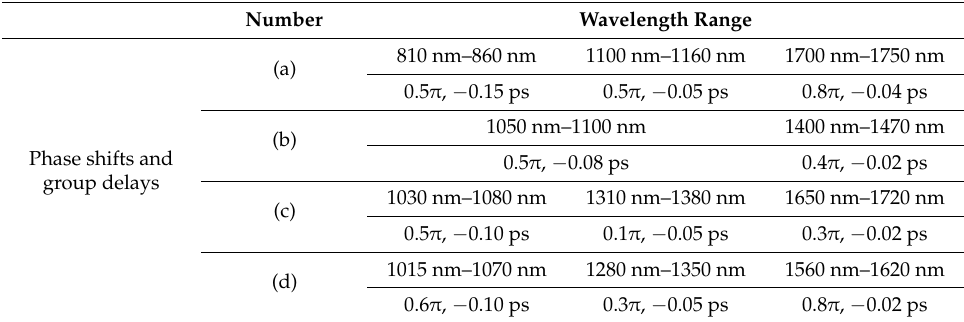
Table 1. The phase shifts and the group delays corresponding to Figures 6 and 7.